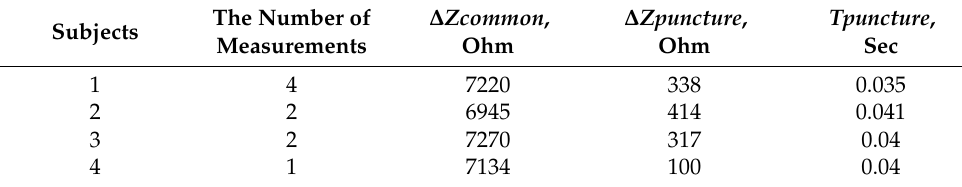
Table 5. Characteristics of electrical impedance for the control